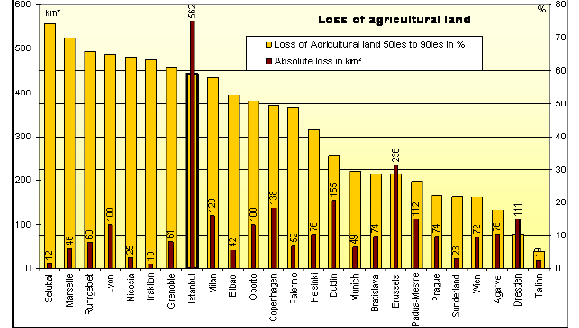
Figure 13: loss of agricultural land in “MOLAND”-cities